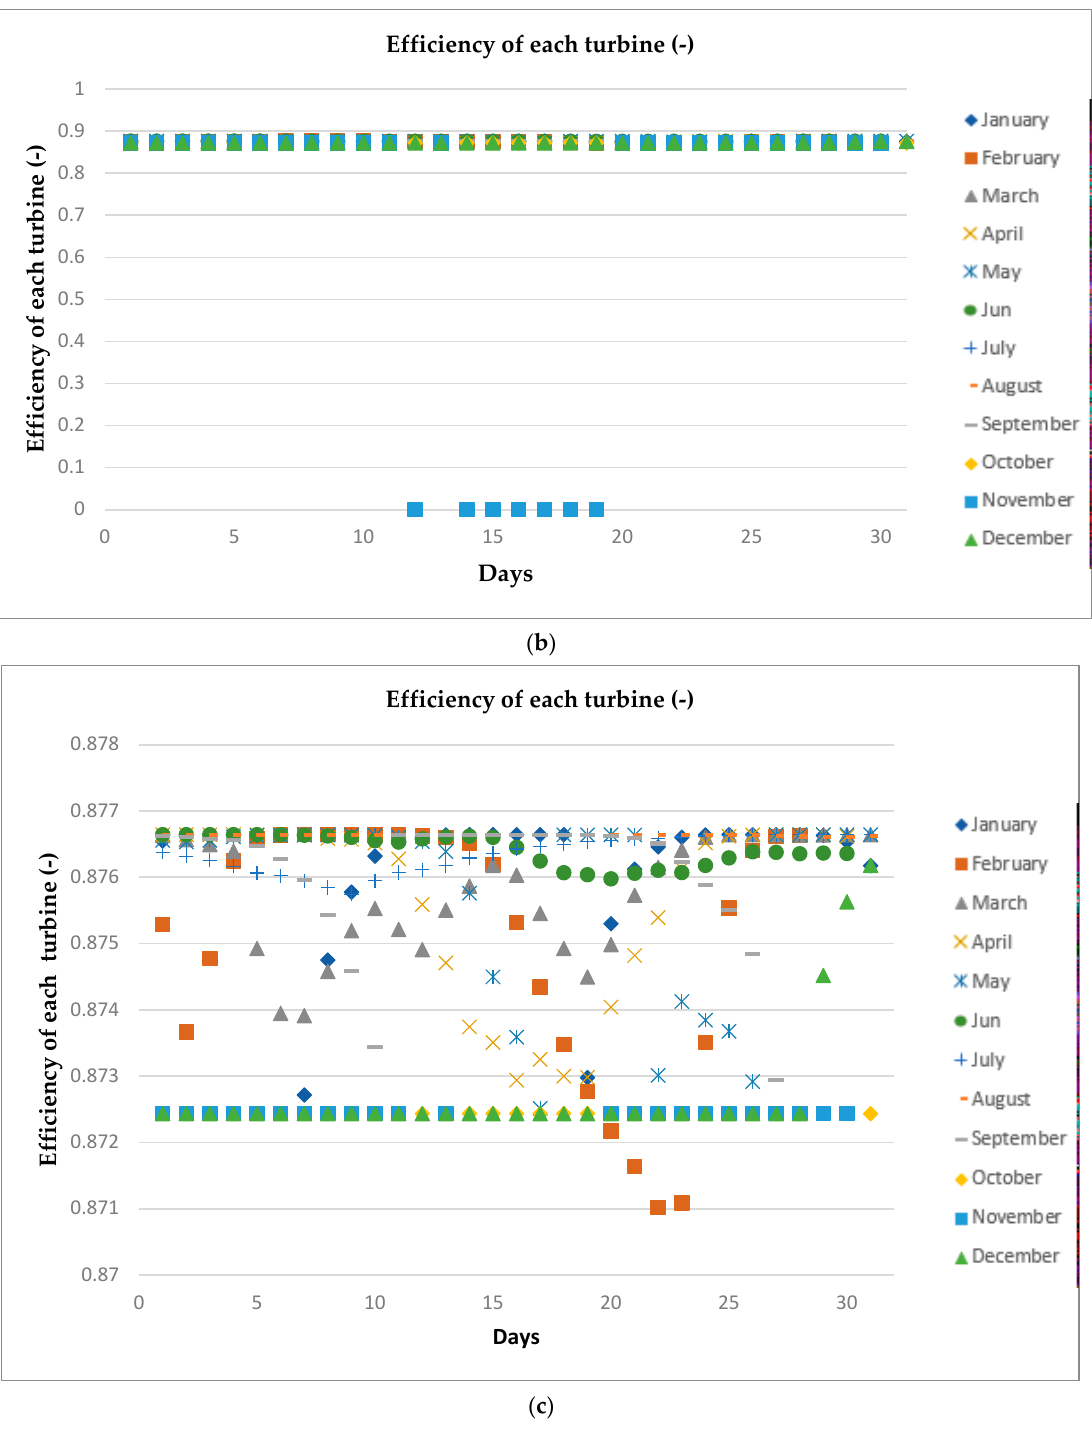
Figure 14. ( a ) Average monthly turbine efficiency histogram and ( b , c ) average daily turbine effi ‐ ciency curve.